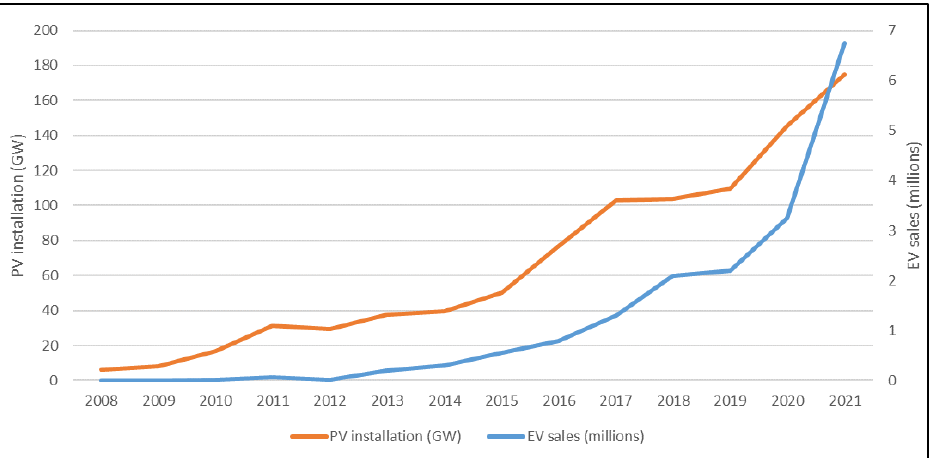
Figure 1. Trends in photovoltaic and electric vehicle sales bolstering interdependency [13].